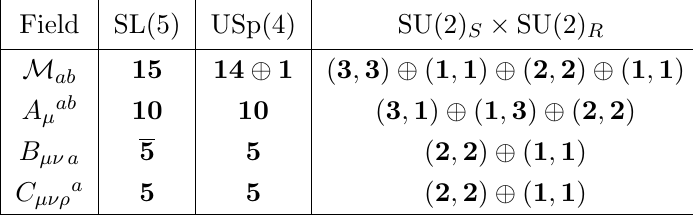
Table 1 . Decomposition of the SL(5) EFT bosonic degrees of freedom under SU(2) S (cid:2) SU(2) R .